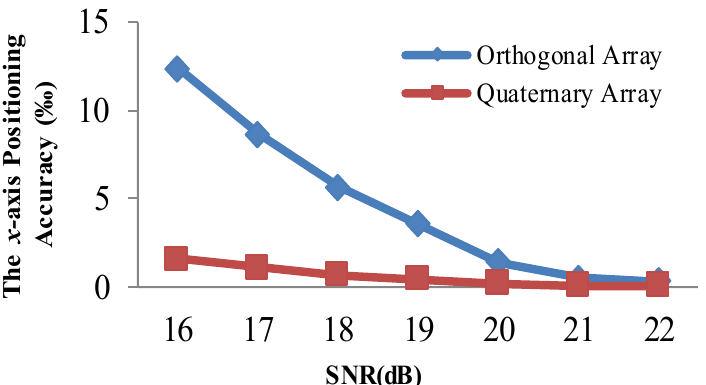
Figure 10. Comparison of the x-axis positioning accuracy of the adaptive residuals for different arrays and different SNR values.